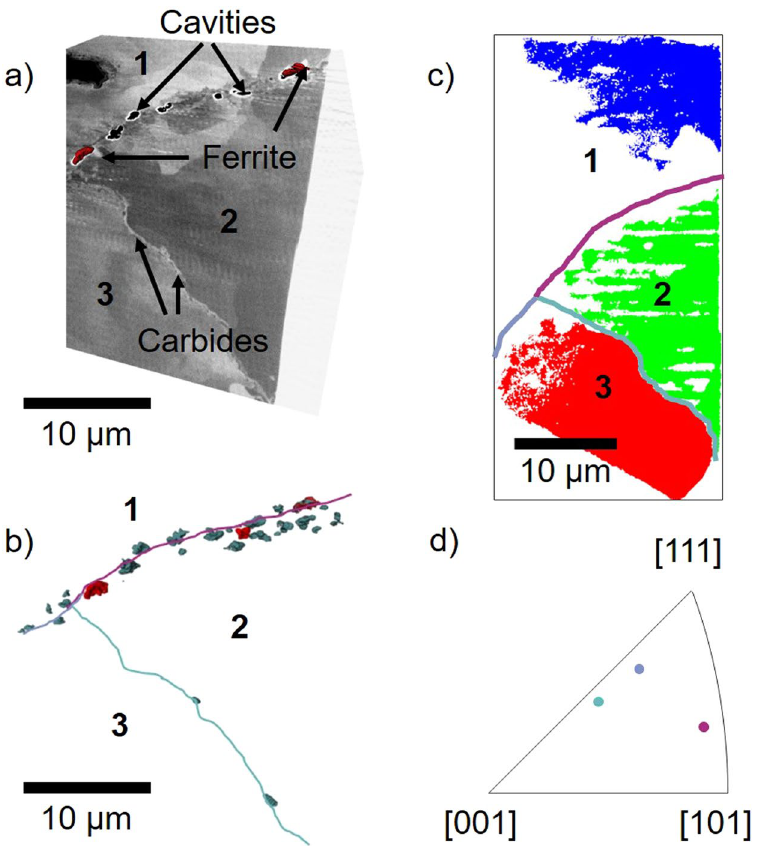
Figure 4. ( a ) Slice through the FIB-SEM volume showing the presence of carbides, ferrite and cavities for the three grain boundaries. The cavities associated with ferrite precipitates are shown in red. ( b ) Volume rendering of segmented cavities (turquoise) in the FIB-SEM volume, displaying those cavities associated with ferrite (red). The three grain boundaries are annotated in 2D (GB 1–2 is magenta, GB 1–3 is blue and GB 2–3 is turquoise). ( c ) The three grains, segmented from the EBSD data, labelled as blue (grain 1), green (grain 2) and red (grain 3). The three grain boundaries are annotated. ( d ) Inverse pole figure showing the axis of misorientation of the three grain boundaries.